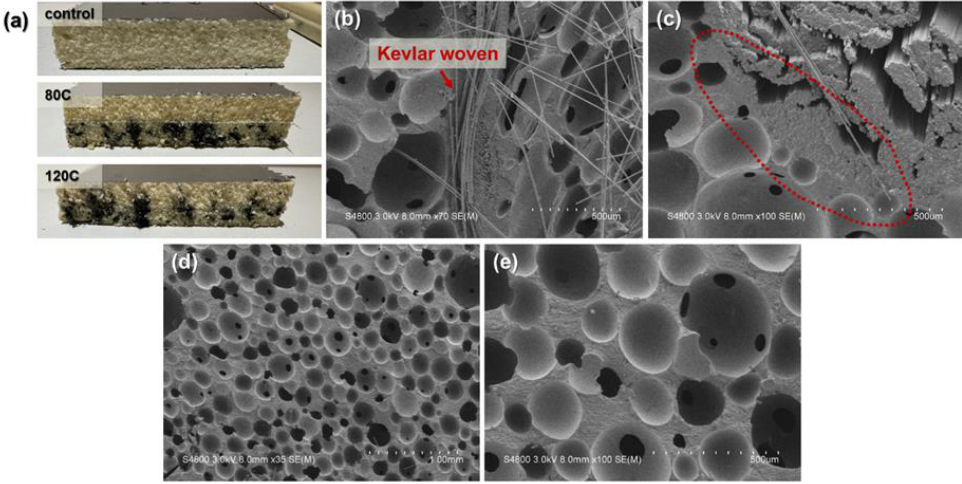
Figure 2. Images of PU foam composites: ( a ) cutting section; ( b ) interface among materials and ( c ) related magnified image, ( d ) and ( e ) SEM images of cells.